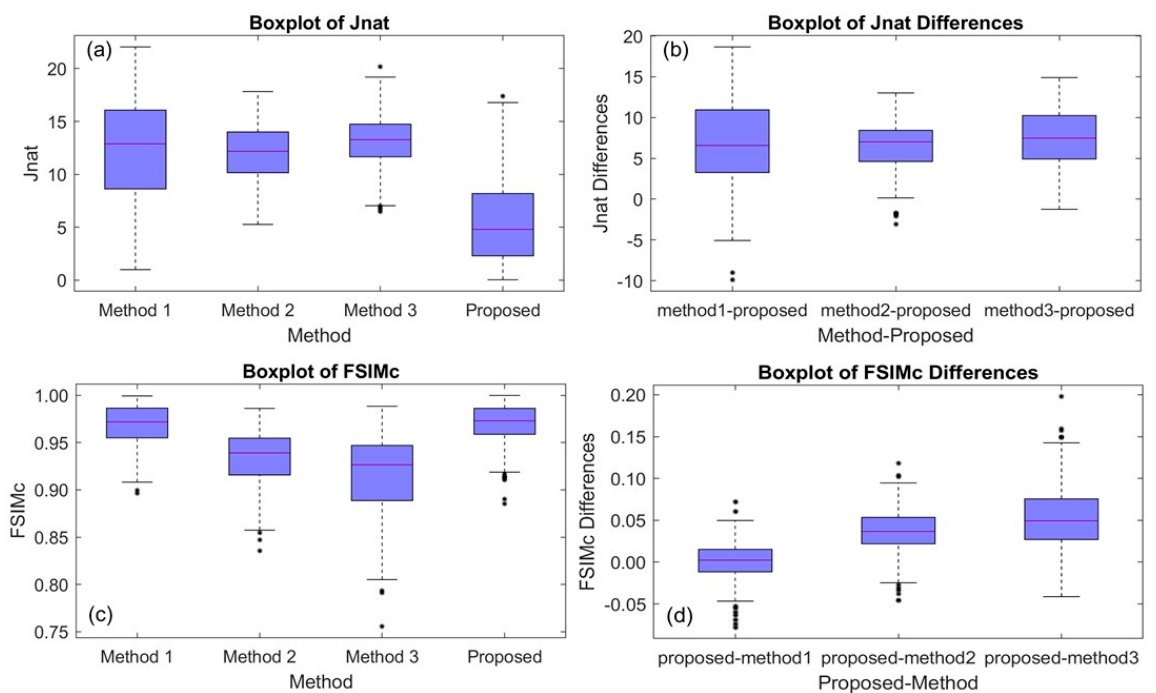
Figure 7. Boxplots for protanopia case considering the McGill’s Flowers and Fruits data sets (in total 195 images): ( a ) the Jnat values (see Table 4), ( b ) Jnat differences between the three competing methods and the proposed method (see Table 5), ( c ) FSIMc values (see Table 4), and ( d ) FSIMc differences between the three competing methods and the proposed method (see Table 5). Table 4. Descriptive Statistics of the Jnat and FSIMc indices for the protanopia case considering the McGill’s Flowers and Fruits data sets (in total 195 images).